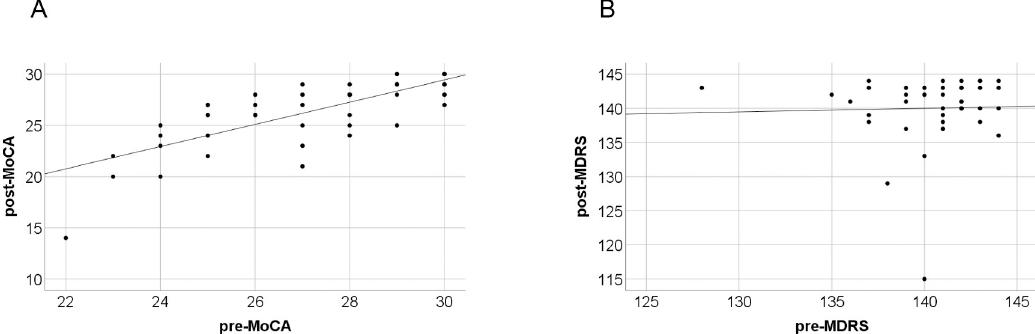
Fig 1. Linear regression of pre- and postoperative MoCA and MDRS. A: Scatterplot of pre- and post-MoCA scores with significant linear regression slope of 1.09 points (p < 0.001). B: Scatterplot of pre- and post-MDRS scores with no significant linear relationship between pre-and post-MDRS scores (p = 0.843). pre: preoperative; post: postoperative.